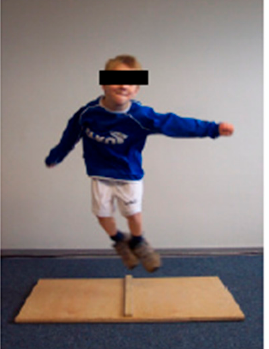
Figure 6. Test setup ‘Lateral jumping’, ©Testmanual KiMo-Test; Dr. rer. nat. S. Dordel, Dr. sports